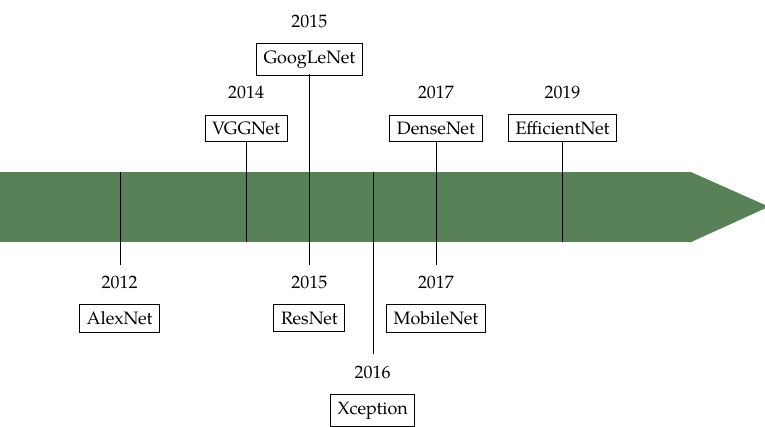
Figure 15. Colour and texture descriptors for visual recognition: deep learning.